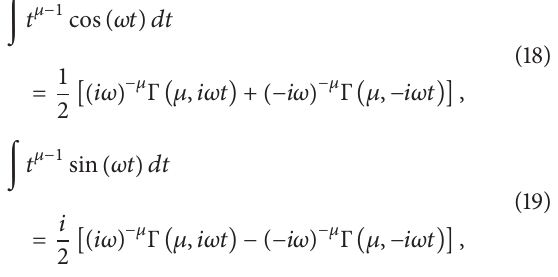
With substitution for definite integral and binomial the- orem, (16) is equivalent